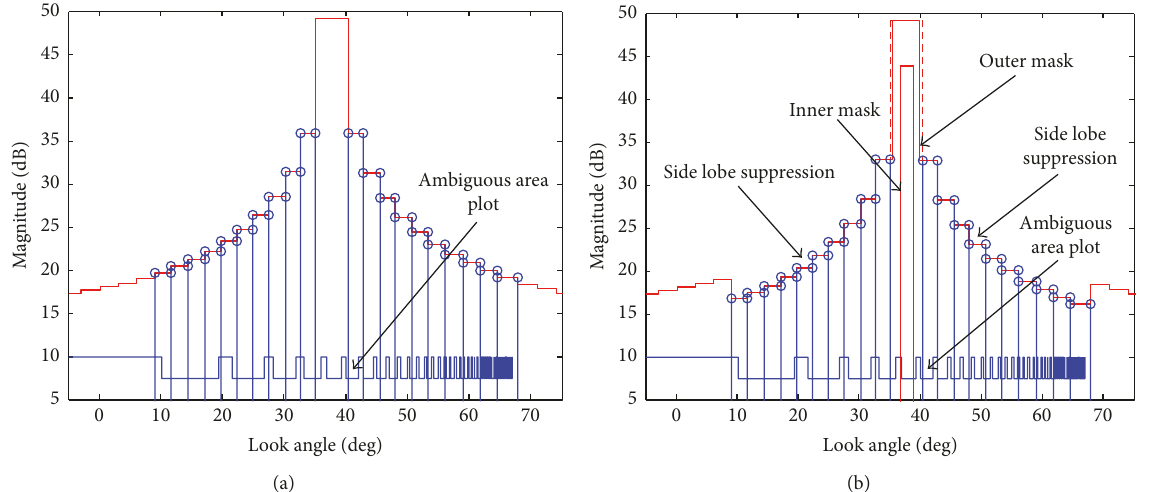
Figure 9: Example of a mask design for beam number 10 of KOMPSAT-5. (a) Initial elevation mask. (b) Designed elevation mask.